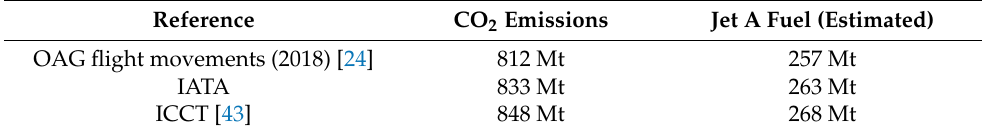
Table 2. CO 2 emissions and Jet A fuel estimated data.